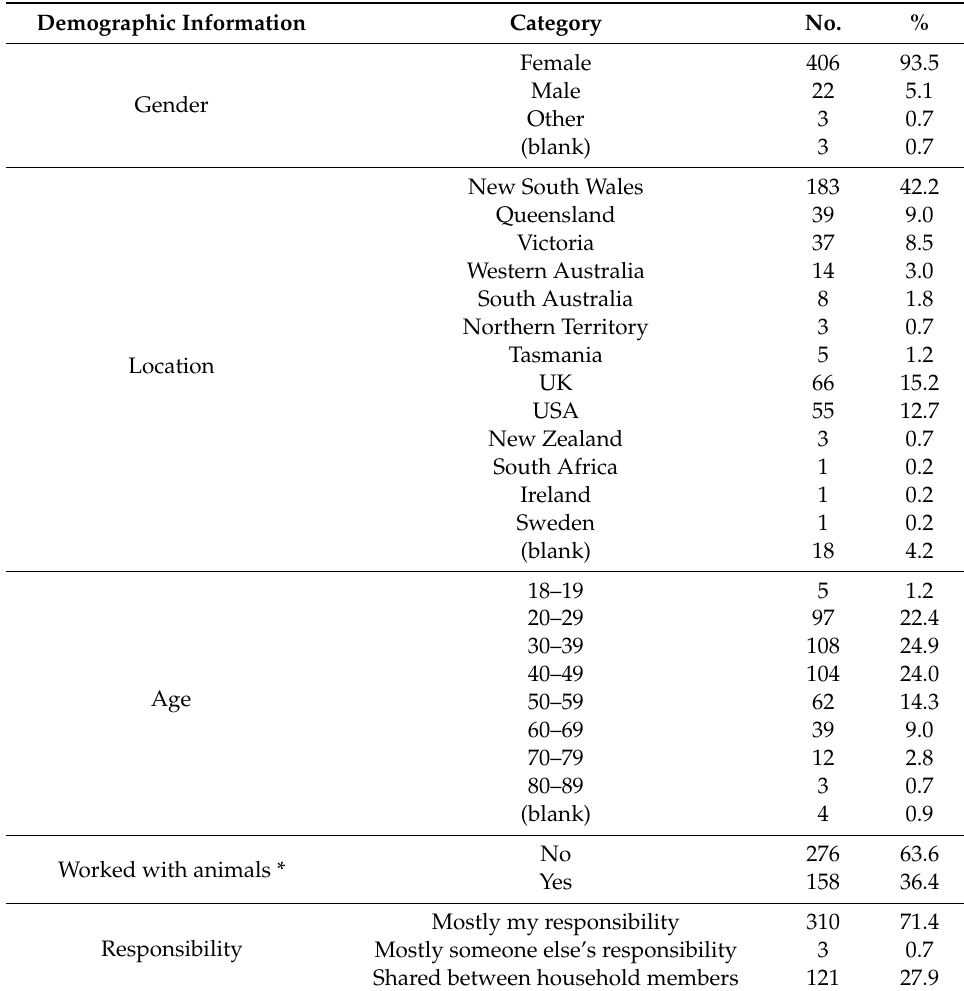
Table 1. Characteristics of respondents in an online survey surrounding the welfare implications of Elizabethan collars on companion dogs and